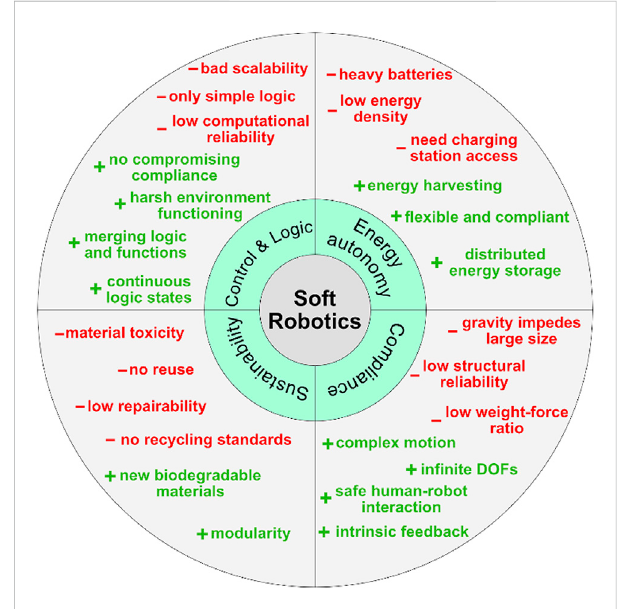
FIGURE 2 Selected positive and negative aspects of soft robotic